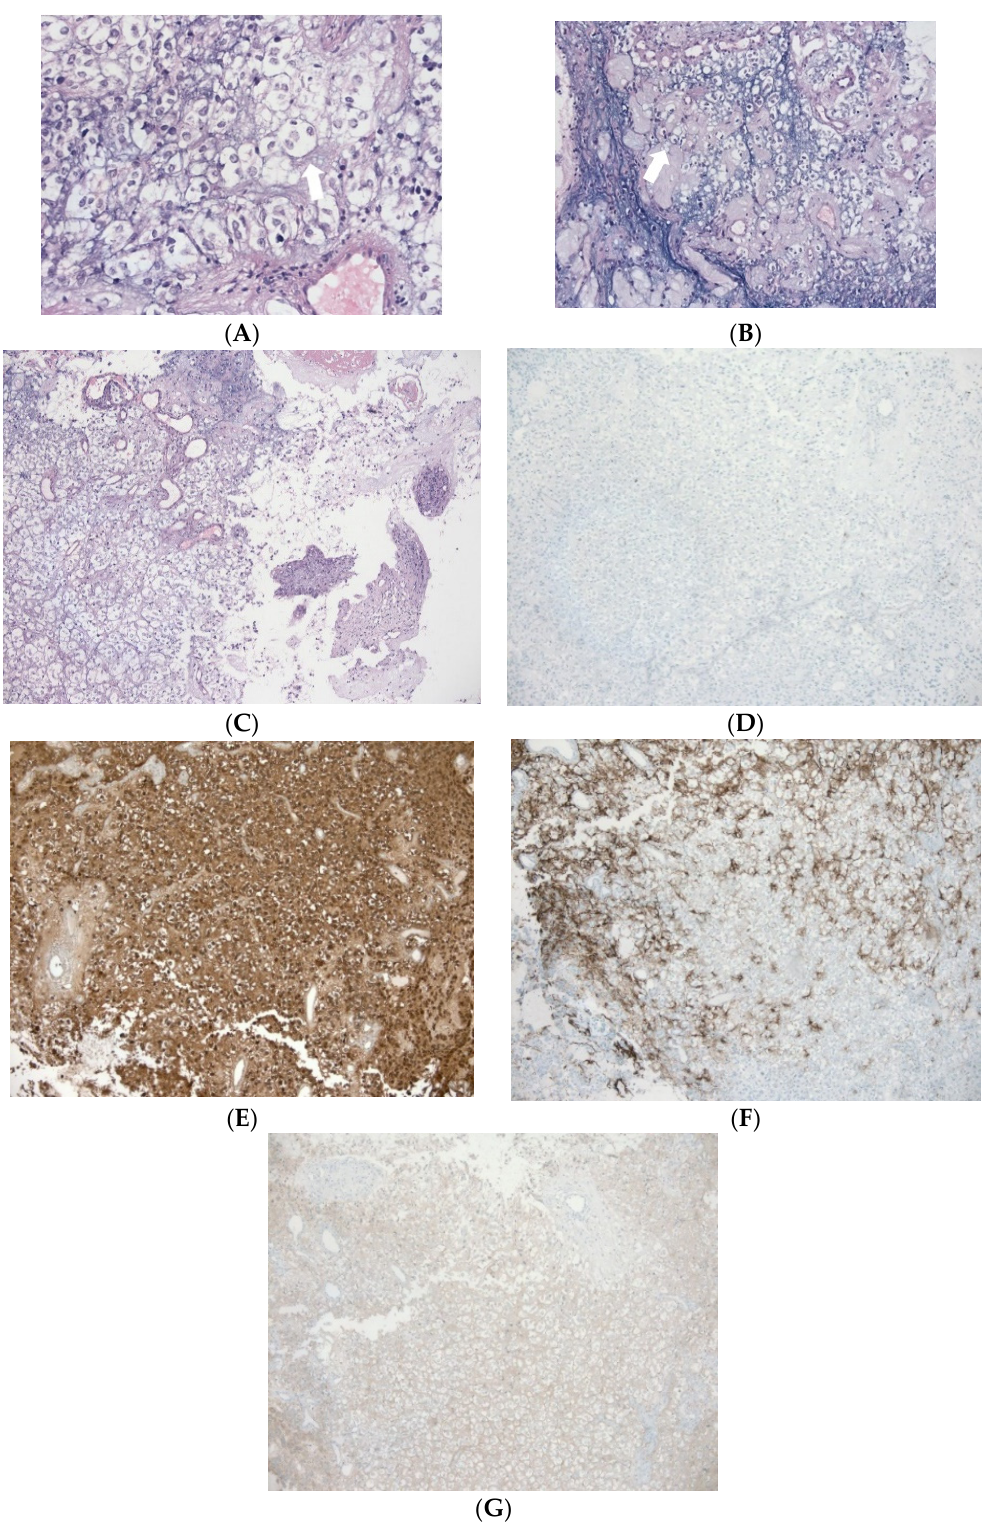
Figure 7. Histological features and immunohistochemical profile of the tumour: ( A – C ) H&E-stained sections demonstrate monotonous oligodendrocyte-like or neurocyte-like tumour cells with round nuclei and clear cytoplasm. Note none microvascular proliferation or significant mitoses in the neoplasm. ( D ) KI67 labelling index was around 2%. ( E ) The tumour cells are strongly immunopositive for S-100 and ( F ) weakly reactive for GFAP and ( G ) synaptophysin. Original magnification: ×100 for ( C,D,E,G ); ×200 for ( B,F ); ×400 for ( A ).